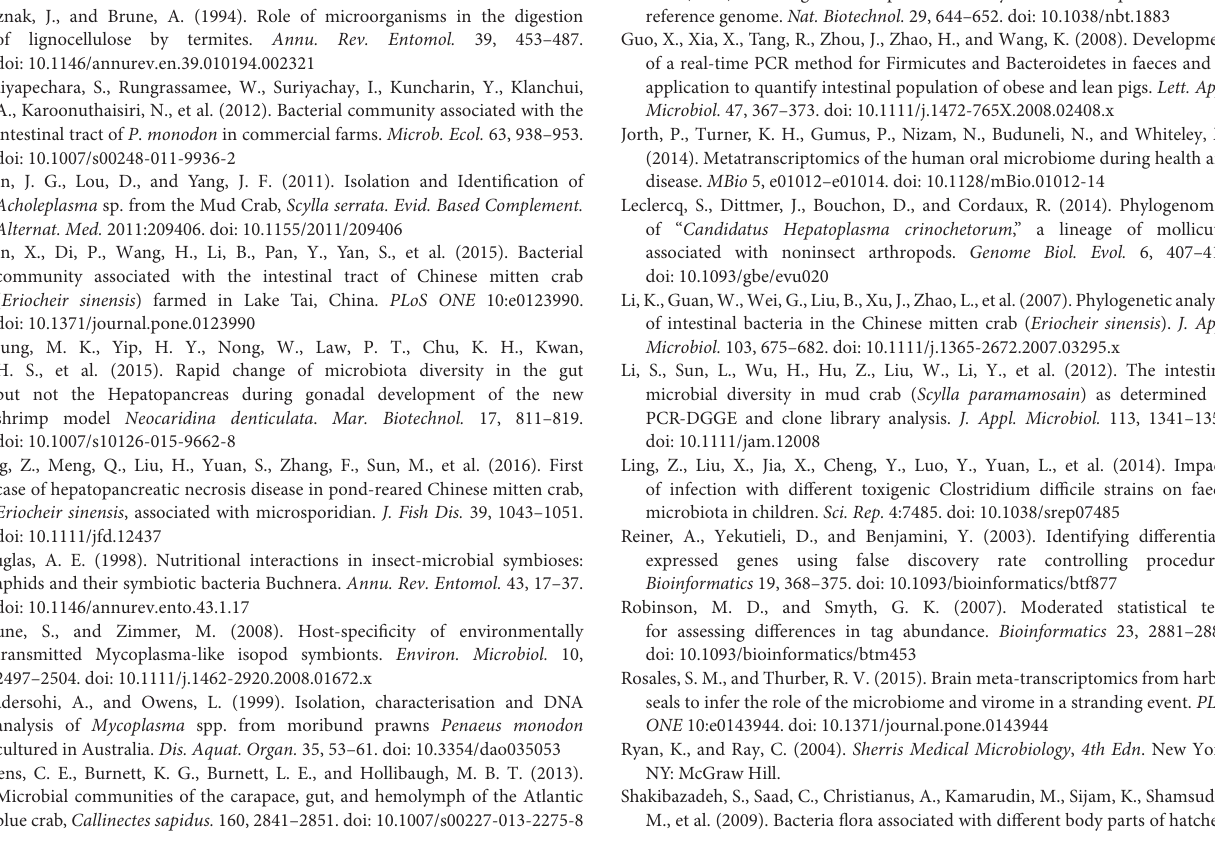
Table S7 | Abundance of phylum in different samples. Table S8 | Abundance of genus in different samples. Table S9 | T -test between HPND group and Healthy grup in phylum level. Table S10 | T -test between HPND group and Healthy grup in genus level.